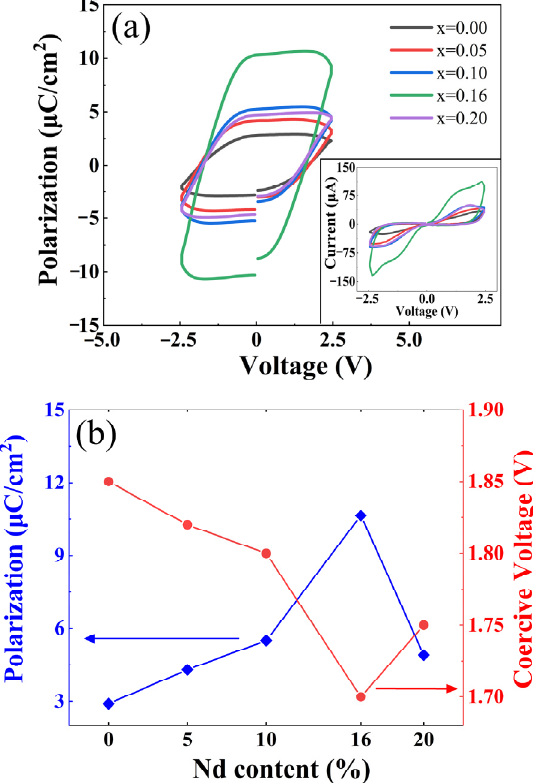
Figure 6. ( a ) The P–V and I–V loops of BNFMO films are calculated from two devices in series. ( b ) The change in the remnant polarization and coercive voltage values with Nd-doping amount.